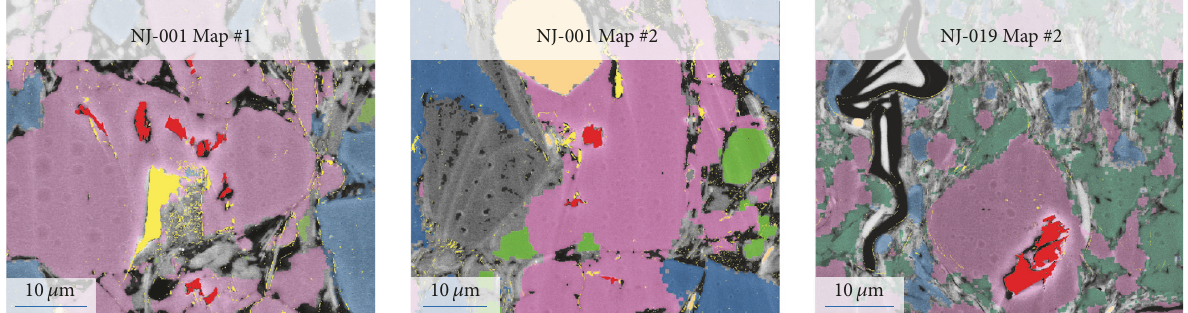
Figure13:ExamplesofporespacecorrectionsillustratedforMap#1andMap#2ofsampleNJ-001andMap#2ofsampleNJ-019.Large,isolated IntraP -pores (red) within albite clasts (pink) are excluded; remaining is the corrected pore space (yellow) used in the CTM calculations. The pore space (yellow/red) appears distorted to fit SE2 image data to the BSE images. CTM calculations were conducted on original pore